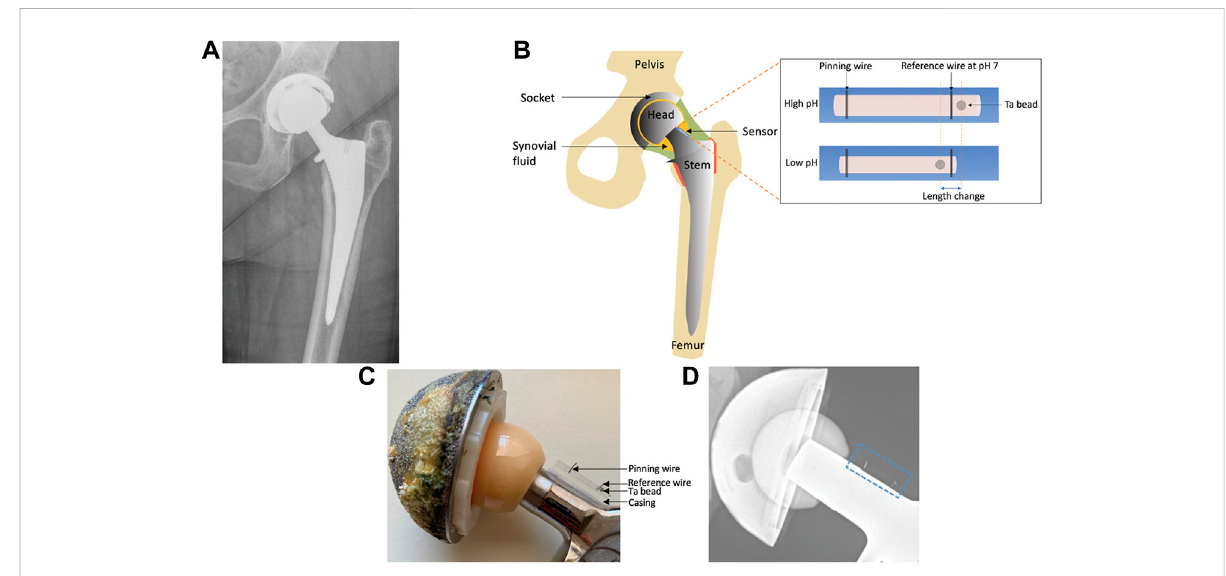
FIGURE 4 (A) X-raypicturesofpeoplewhohavearti fi cialhipjoints. (B) AprosthetichipjointwithasynovialpHsensorisshownschematically. (C) Imageof ahipprosthesiswithanassociatedpHsensor. (D) PhotographofahipprosthesiswithapHsensorattached(Wijayaratnaetal.,2021).Copyright2021, Advanced Functional